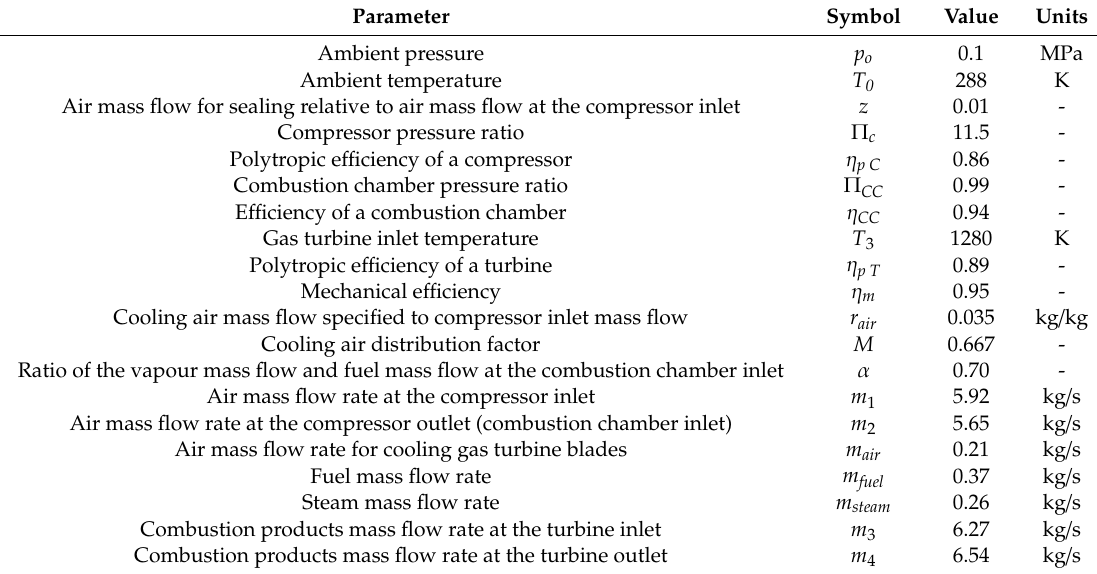
Table 3. Inlet parameters values for supere ffi cient basic humidified Brayton